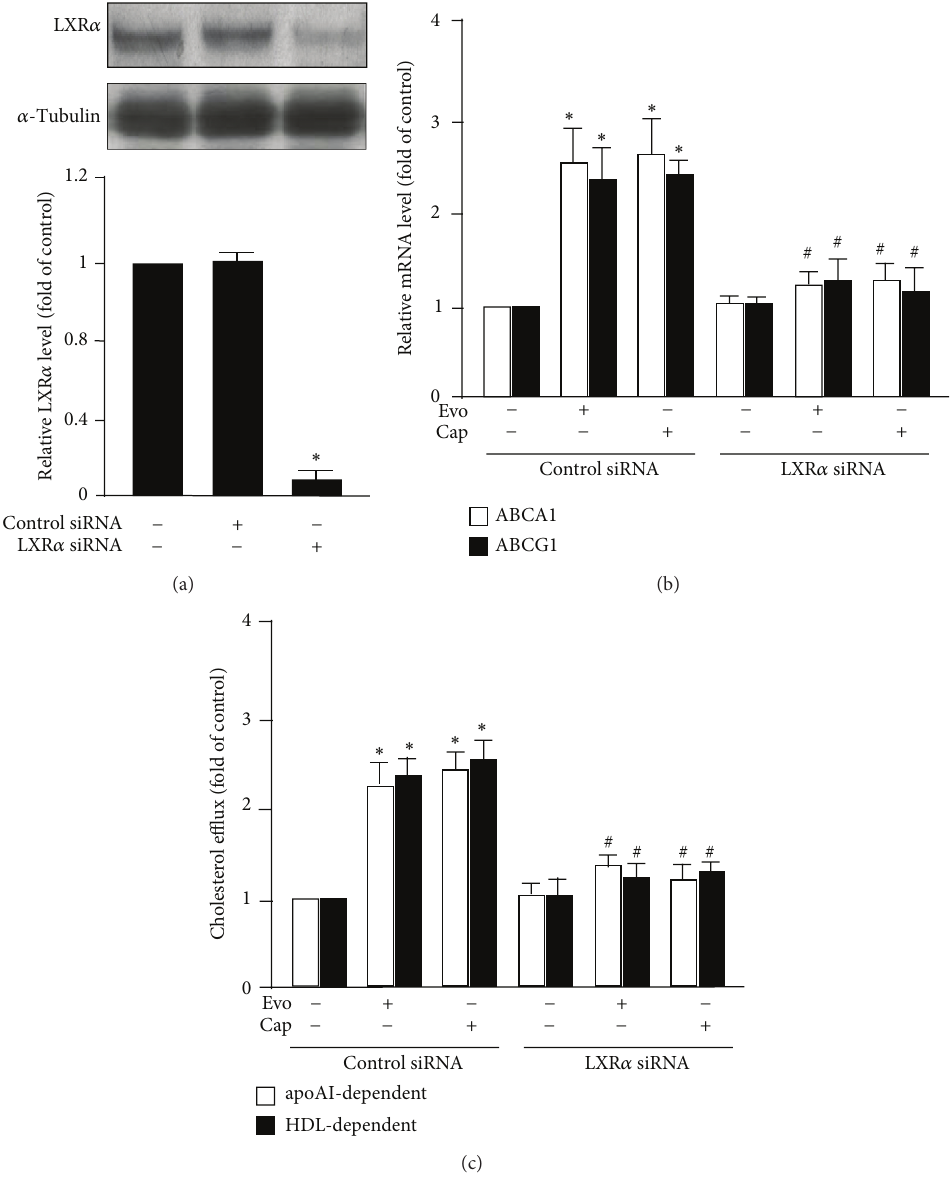
Figure 7: Knockdown of LXR 𝛼 abolishes the protein expression of ABCA1 and ABCG1 and attenuates lipid accumulation by TRPV1 agonists. BMDMs were preincubated with control siRNA (50nmol/L) or LXR 𝛼 siRNA (50nmol/L) for 24h, followed by evodiamine or capsaicin treatmentforadditional24 h.(a)WesternblotanalysisofproteinexpressionofLXR 𝛼 .(b)RT-PCRanalysisofmRNAexpressionofABCA1and ABCG1. (c) ApoAI- and HDL-dependent cholesterol efflux was evaluated by use of NBD-cholesterol. Data are mean ± SD from 5 independent experiments. ∗ 𝑃 < 0.05 versus control siRNA-treated cells, # 𝑃 < 0.05 versus control siRNA-treated cells with evodiamine or capsaicin